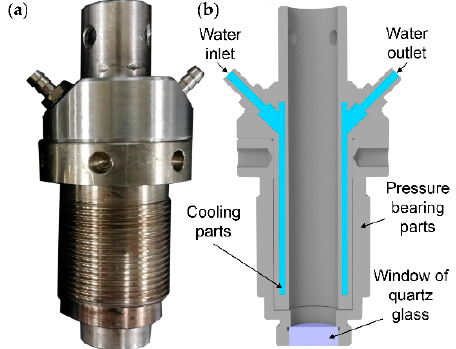
Figure 1. The high-temperature/pressure-resistant shell. ( a ) The physical photo, ( b ) the schematic